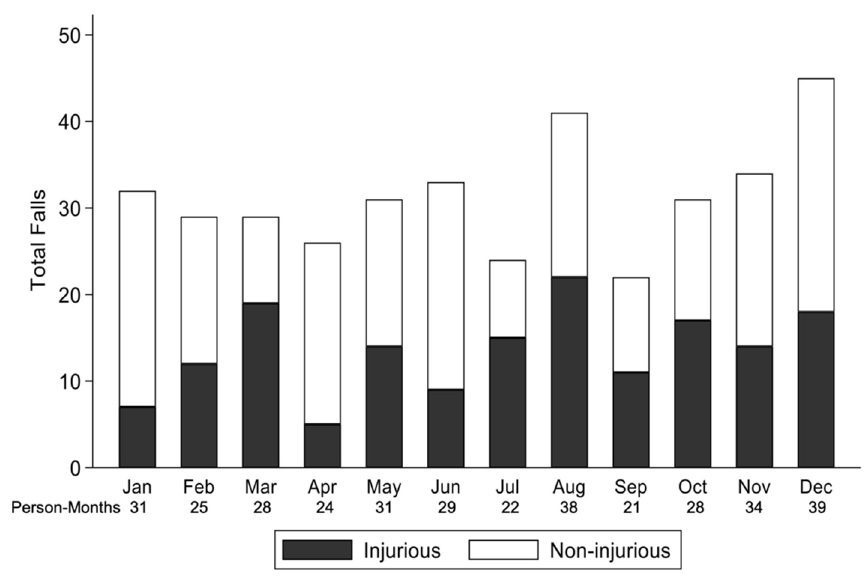
Figure 3. Total falls, classified as injurious vs. non-injurious falls, by month across all study years and study participants.